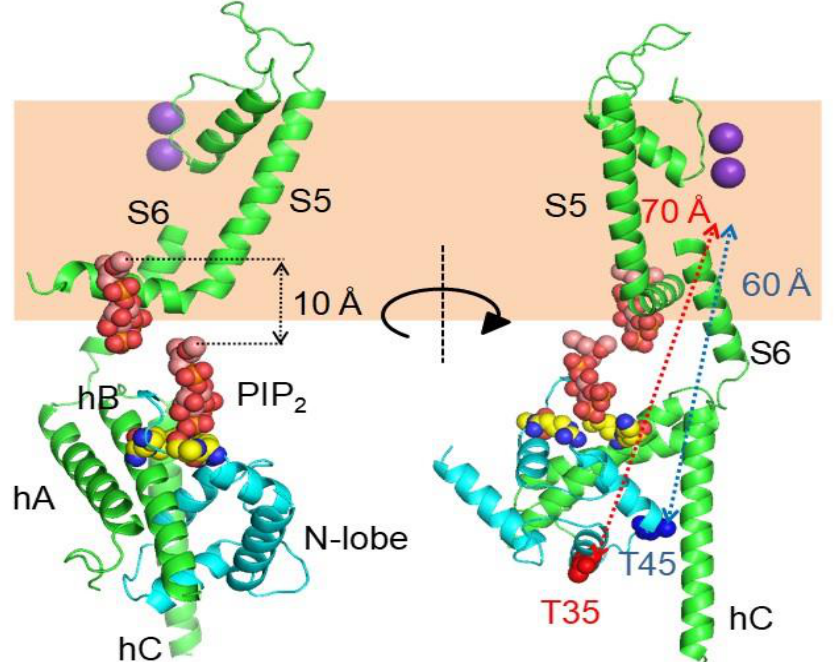
Figure 13. Two views of hypothetical docking of PIP 2 with the channel at the site in which CaM participates. The pore residues (GYG) were used as a reference to align the Kir structure (PDB 3SYA) to KCNQ1 (PDB 5VMS), placing a reference PIP 2 molecule adjacent to the S4 / 5 linker. The second PIP 2 molecule was placed manually at the CaM / helix B-C linker site. Only the N-lobe of CaM is shown (cyan). On the right, the distances for T35 and T45 to the putative inner TEA binding site are indicated. The purple balls represent K + ions. The orange box represents the possible location of the